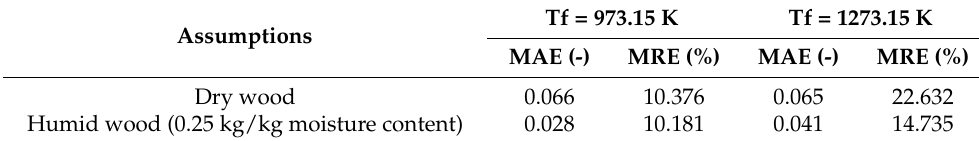
Table 3. Mean errors depending on whether moisture content in samples is considered or not.